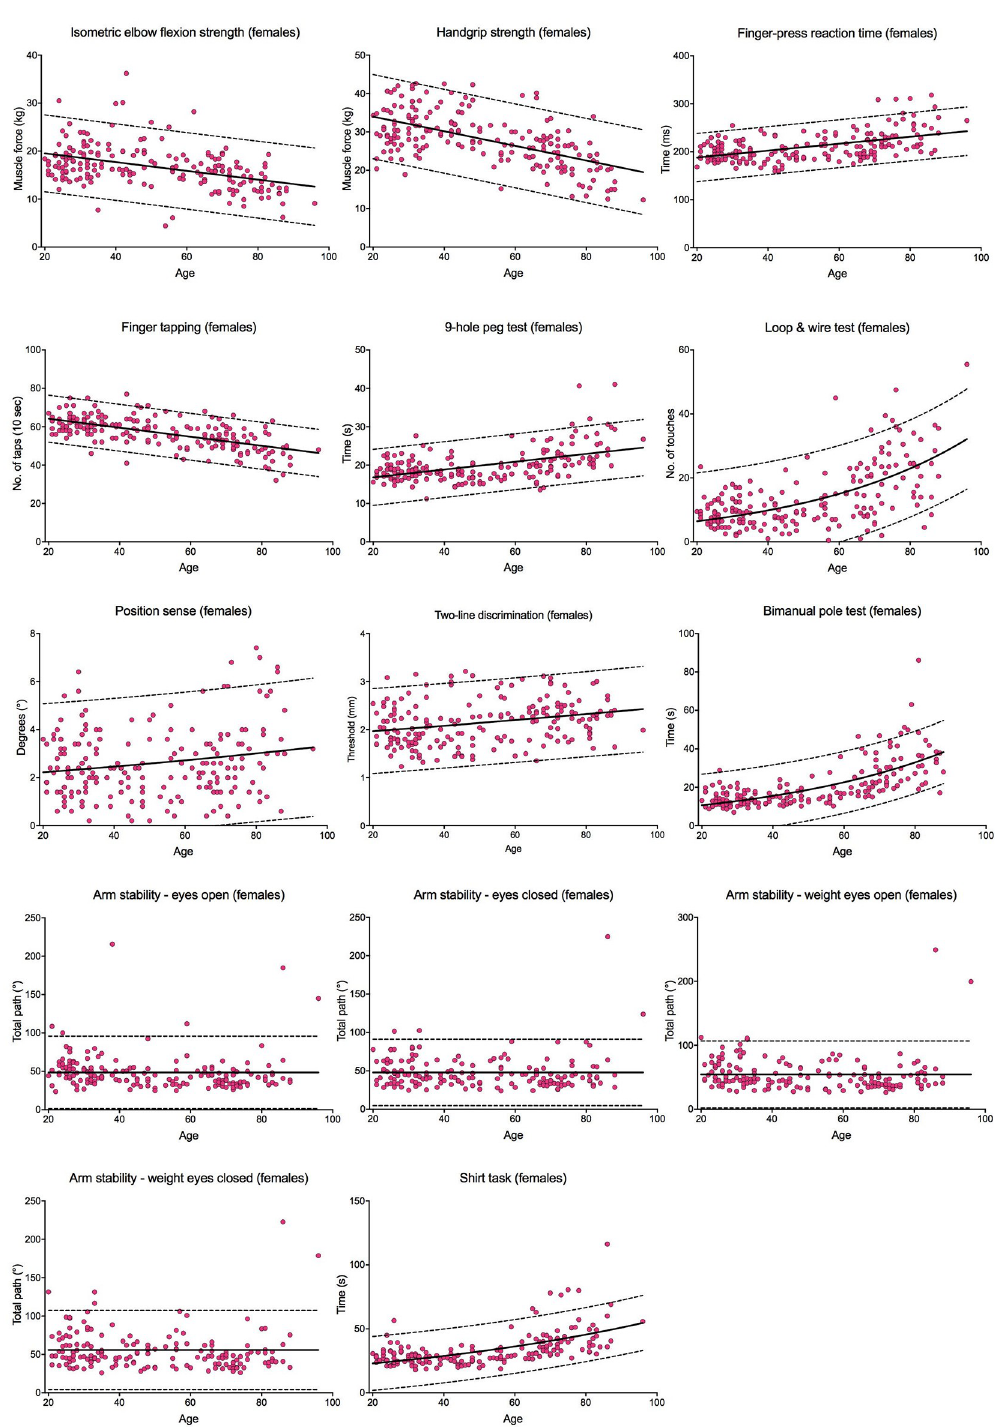
Fig 10. Individual test performance plotted against age in females. Individual participant scores are plotted against age for each of the continuously scored tests. The continuous black line represents the regression line and the broken black lines represent the 95% prediction